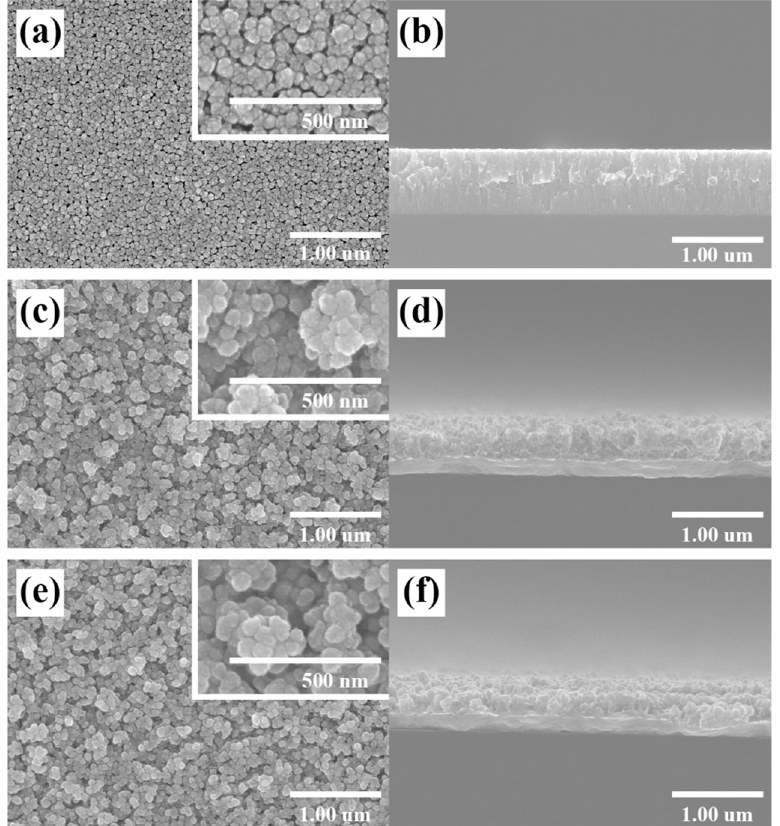
Figure 3. FESEM image of the surface ( a ) and cross-section ( b ) of the ZnO film; FESEM image of the surface ( c ) and cross-section ( d ) of the ZnO NS on which the H 2 reduction process was performed for five minutes; FESEM image of the surface ( e ) and cross-section ( f ) of the ZnO NS on which the H 2 reduction process was performed for 10 min.